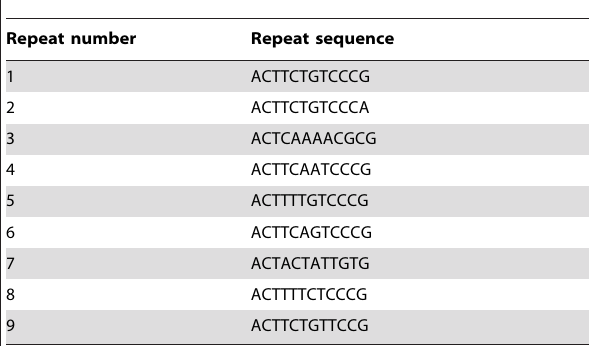
Table 1. Summary of CSP repeat sequences.